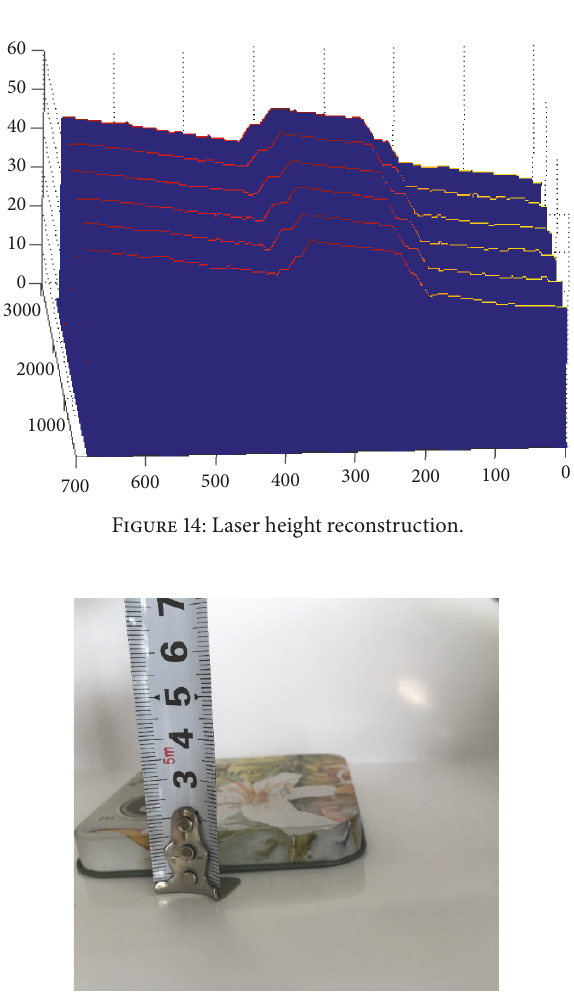
Figure 15: Actual cuboid height.